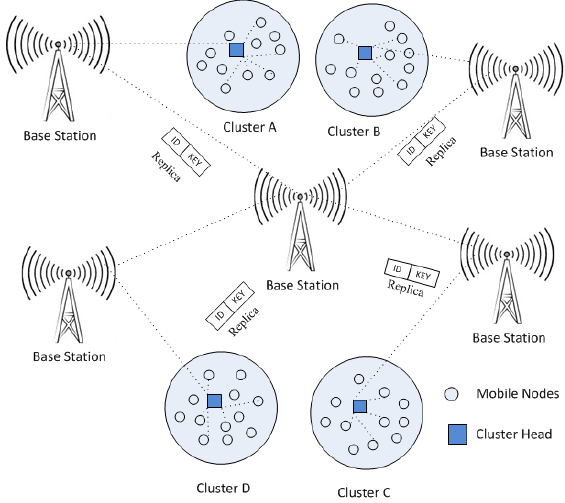
Figure 5. Secure network by broadcasting message about clone. Algorithm 3 Network Protection (Third Level